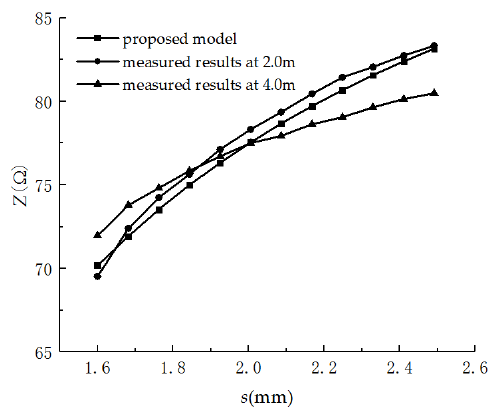
Figure 10. The comparison between the measured results and the theoretically calculated results.